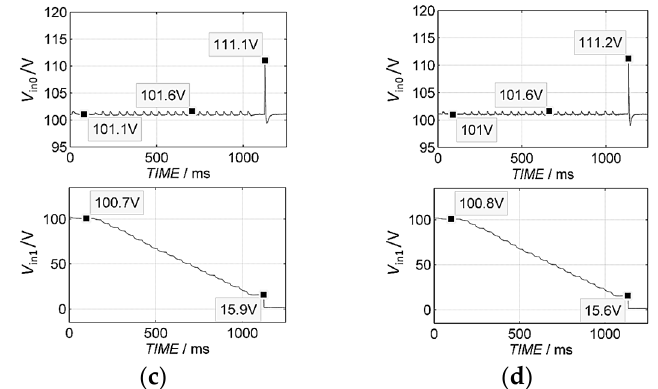
Figure 13. The experimental results with the loads of ( a ) 0 W, ( b ) 25 W, ( c ) 50 W, and ( d ) 75 W, respectively (2 modules).